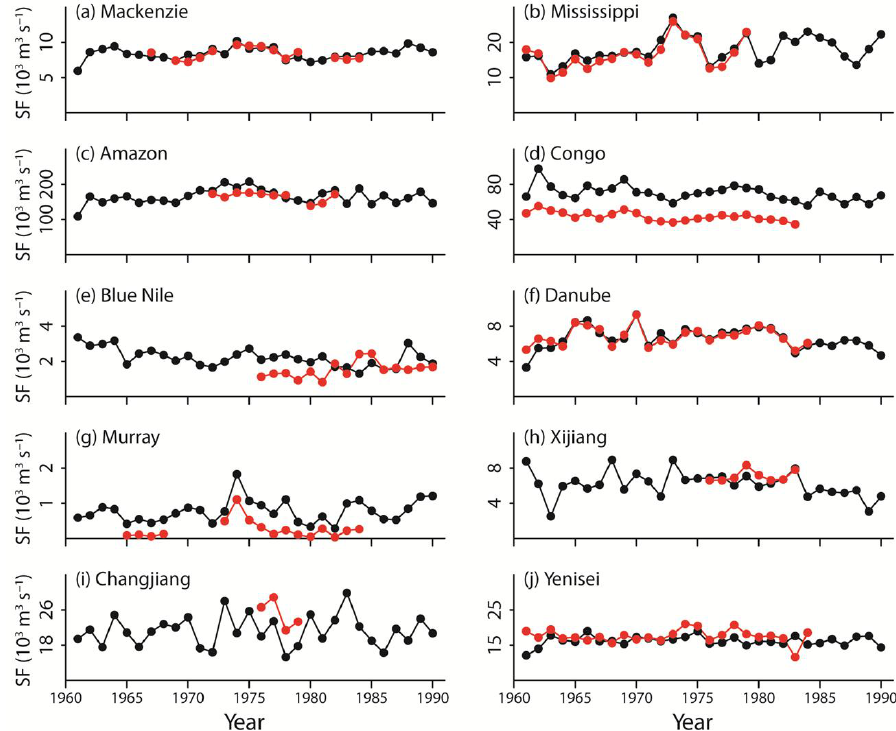
Fig. 10. Comparison between LH-simulated (black dotted line) and observed (red dotted line) annual discharges for 10 large rivers worldwide. The observed annual discharges are from RivDis2.0 database, available from http://www.sage.wisc.edu/riverdata/.